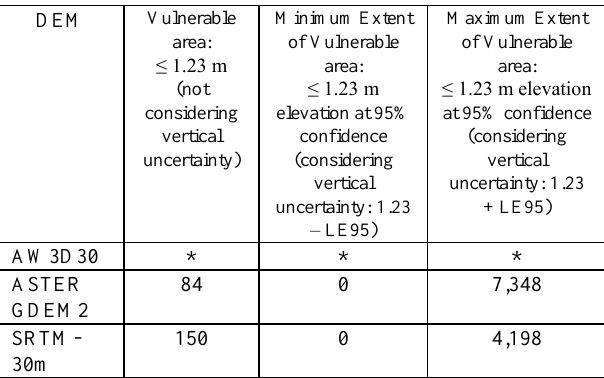
Table 5. The area (in km 2 ) vulnerable to 1.23 m SLR, both with and without consideration of vertical uncertainty. (*Areas were not computed for AW3D30 since the DEM contained Figure 4. DEM errors plotted versus elevation using all the 2,076 ground control points.